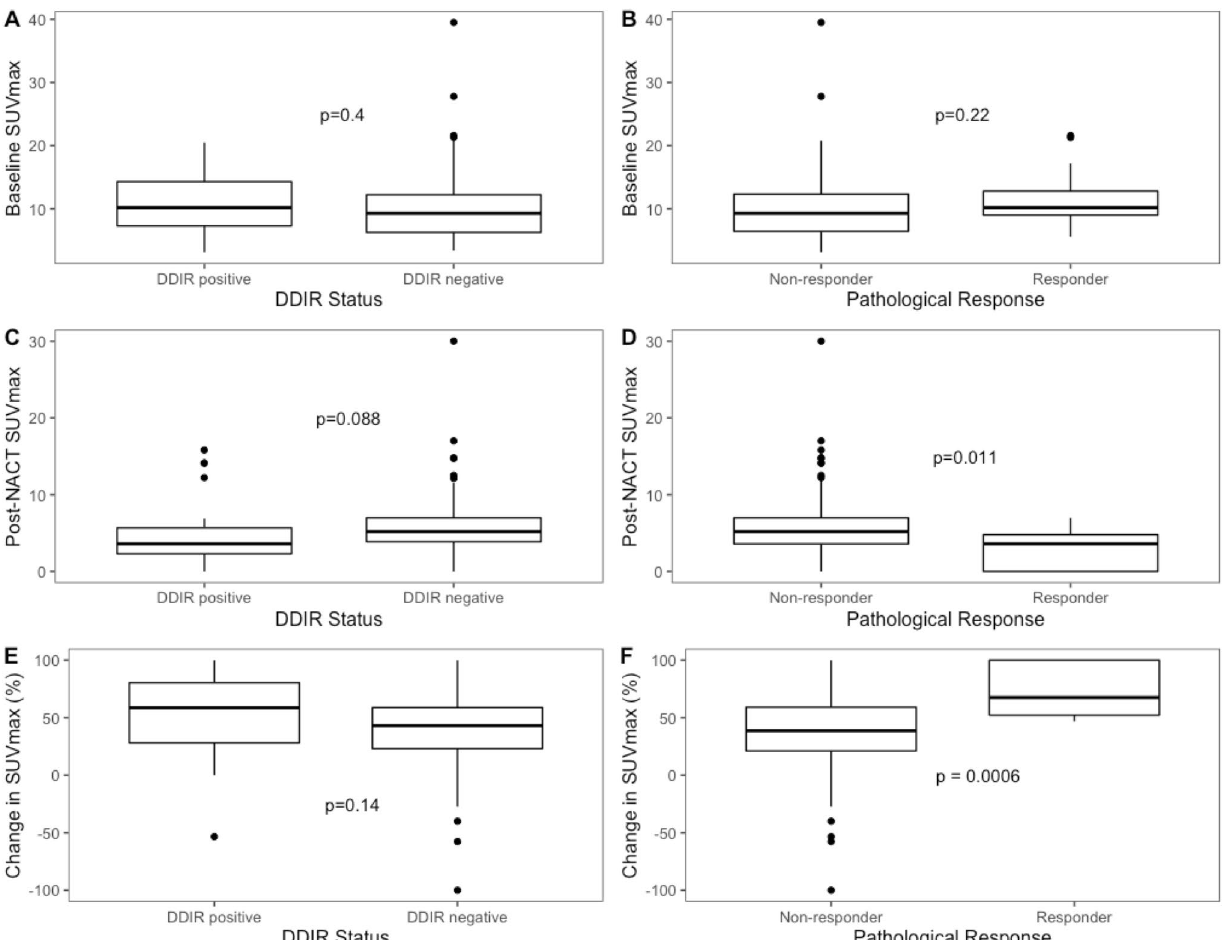
Figure 3. Boxplots of differences between baseline, post neo-adjuvant chemotherapy and change in SUVmax for DDIR status and pathological response (unadjusted p-values shown within